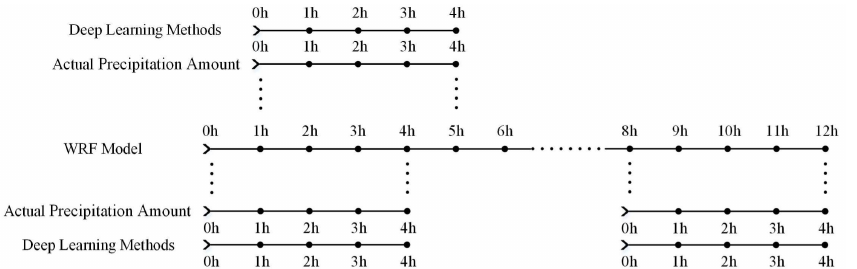
Figure 6. Schematic diagram of comparison method between deep learning methods and the WRF model.